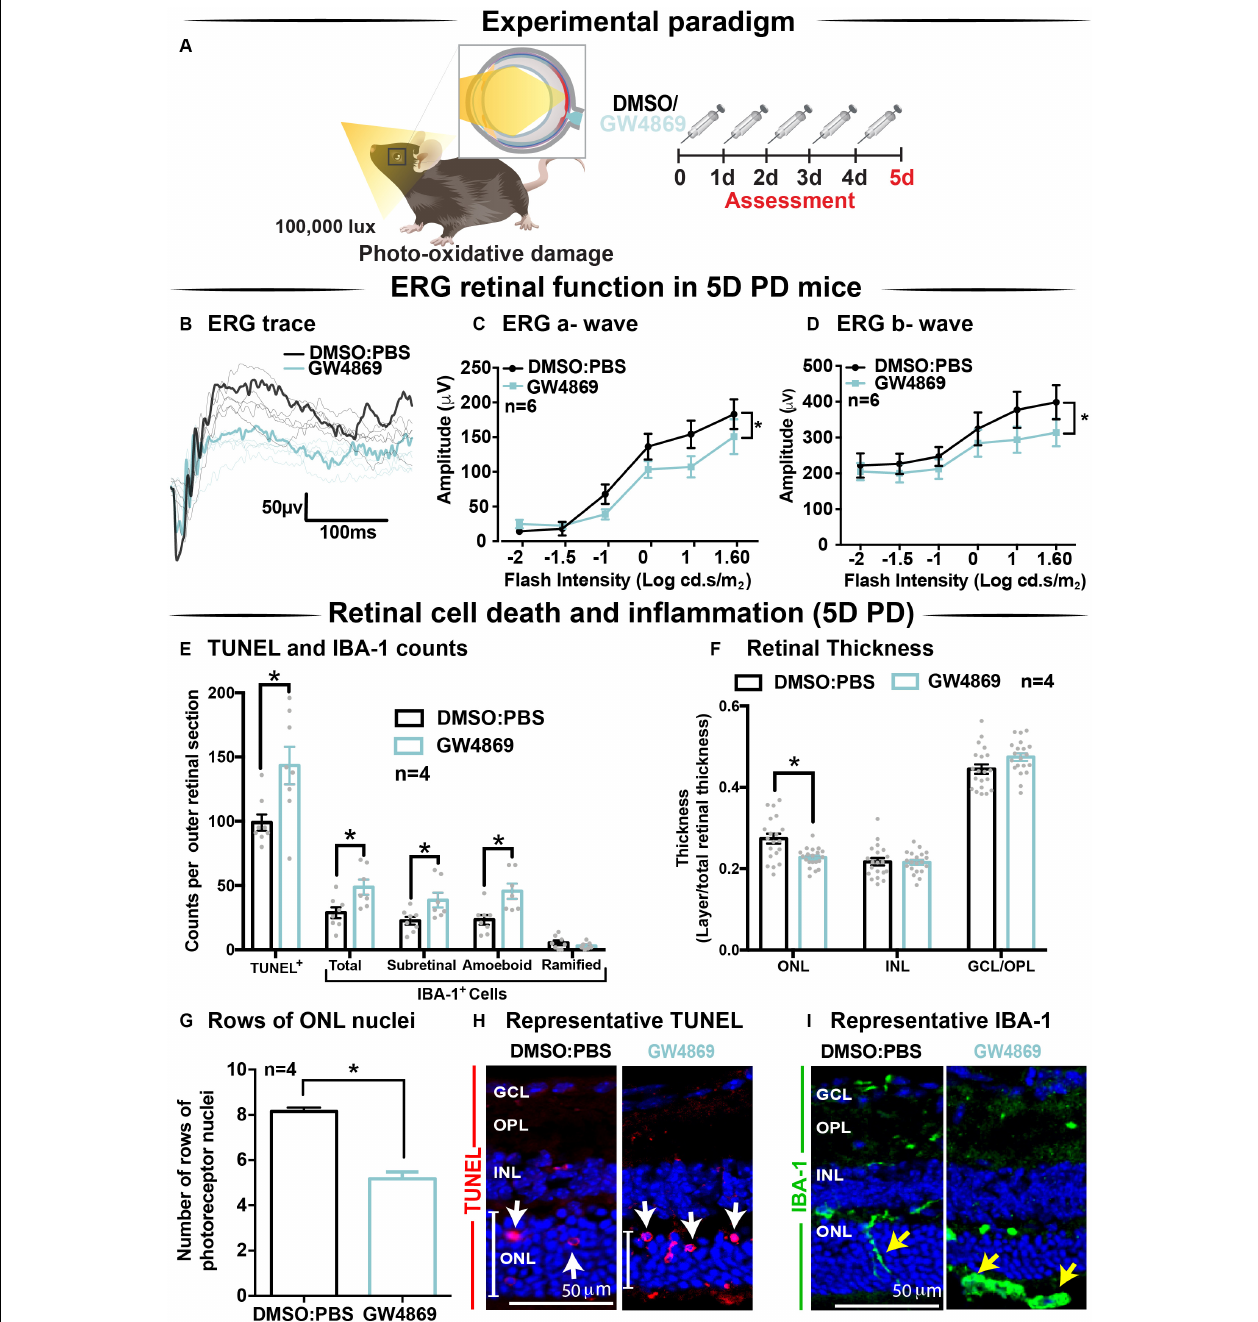
FIGURE 6 | Exosome inhibition via the use of GW4869 in mice subjected to 5 days photo-oxidative damage reduces retinal function and increases cell death and immune cell recruitment. (A) Experimental paradigm with red retinal labeling indicating lesion site. Following 5 daily intraperitoneal injections of GW4869 (1.25 mg/kg), retinal ERG function, (B) shown in representative ERG traces, was significantly reduced for both (C) a-wave and (D) b-wave responses, compared to DMSO controls in 5D PD mice ( P < 0.05, n = 6). (E) There was a significant increase in the number of TUNEL + cells in the ONL, as well as a significant increase in the total number, number of subretinal, and number of amoeboid but not ramified IBA-1 + cells in the outer retina in GW4869-injected mice compared to DMSO controls following 5D PD ( P < 0.05, n = 4). (F) There was a significant reduction in the thickness of the ONL of GW4869-injected 5D PD mice compared to DMSO controls ( P < 0.05, n = 4), however, no change was observed in the thickness of the INL or GCL between these groups ( P > 0.05, n = 4). (G) The number of photoreceptor row nuclei in the ONL was also significantly reduced in GW4869-injected 5D PD mice compared to DMSO controls ( P < 0.05, n = 4). Representative confocal images show (H) increased levels of TUNEL + cells (while arrow) and reduced ONL thickness (white line) as well as (I) increased number of IBA-1 + cells in the outer retina, in GW4869-injected mice following 5 days of PD. Representative confocal images are taken in the superior outer retina, 1 mm from optic nerve head. Scale bars = 50 µ M. * denotes = P <